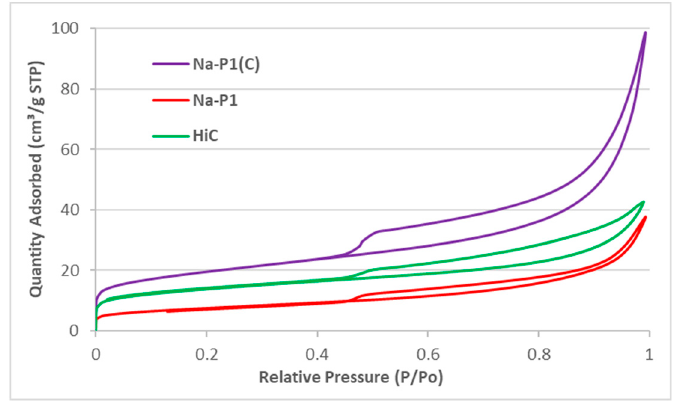
Figure 7. N 2 adsorption/desorption isotherms of the studied materials.